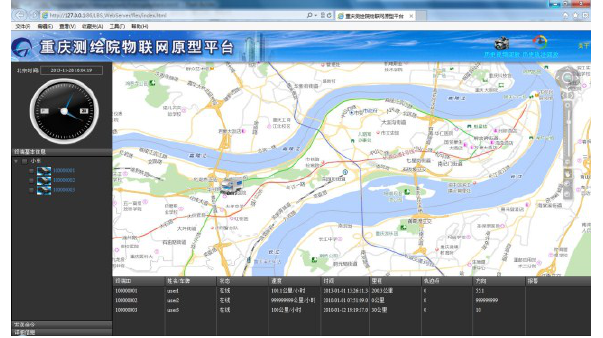
Figure 3. The application of Connected